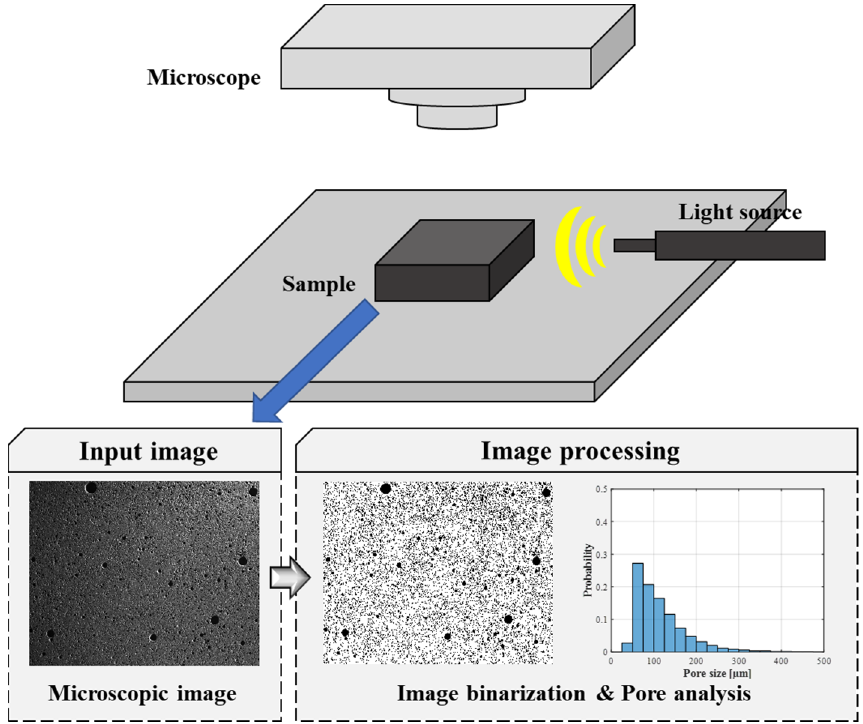
Figure 1. Schematic diagram for the microstructural image processing method.